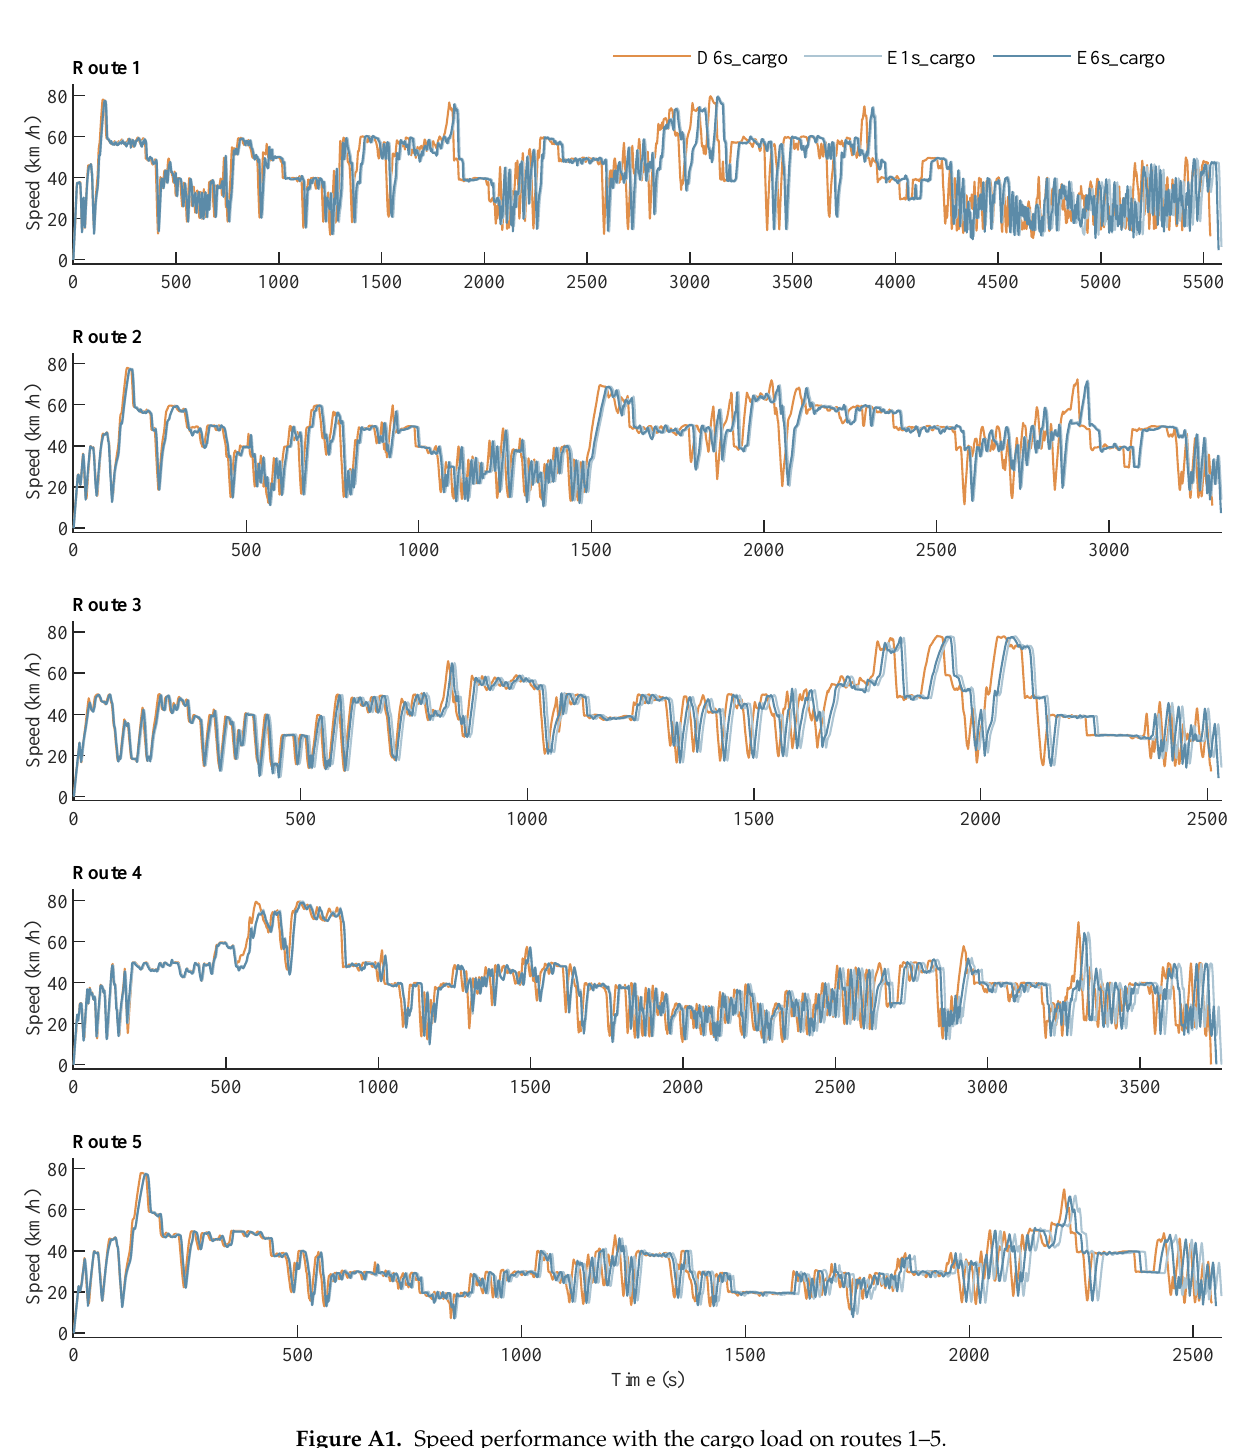
Figure A1. Speed performance with the cargo load on routes